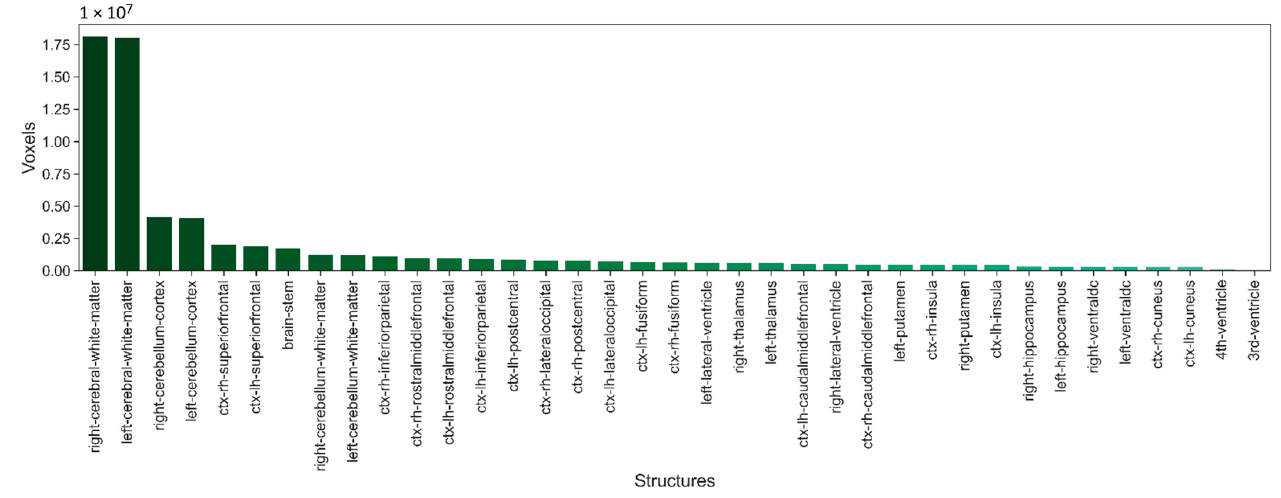
Figure 3. Number of voxels for each of the 37 selected structures from Mindboggle-101 dataset.